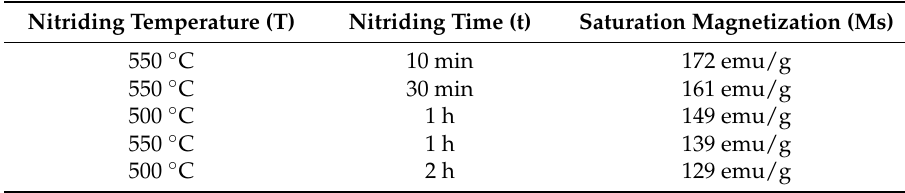
Table 1. Relationship between nitriding temperature, nitriding time, and saturation magnetization of FeSiN